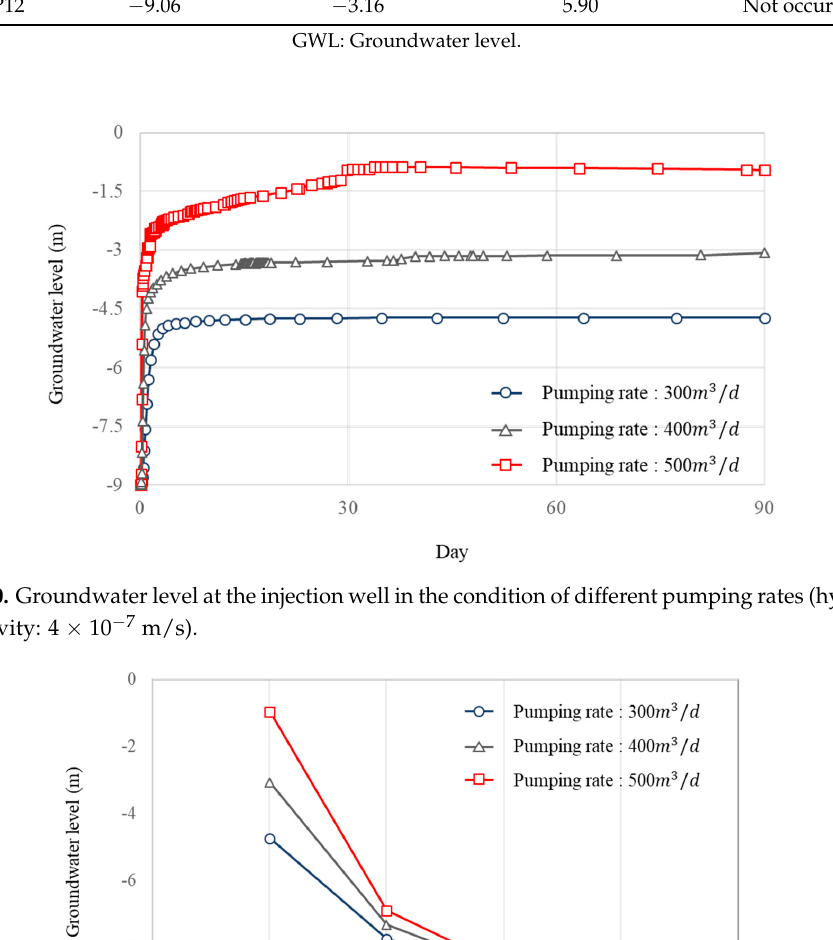
Figure 12. Groundwater level at the injection well in the presence or absence of the pairing system (hydraulic conductivity: 2 × 10 − 7 m/s; pumping rate: 500 m 3 /d).